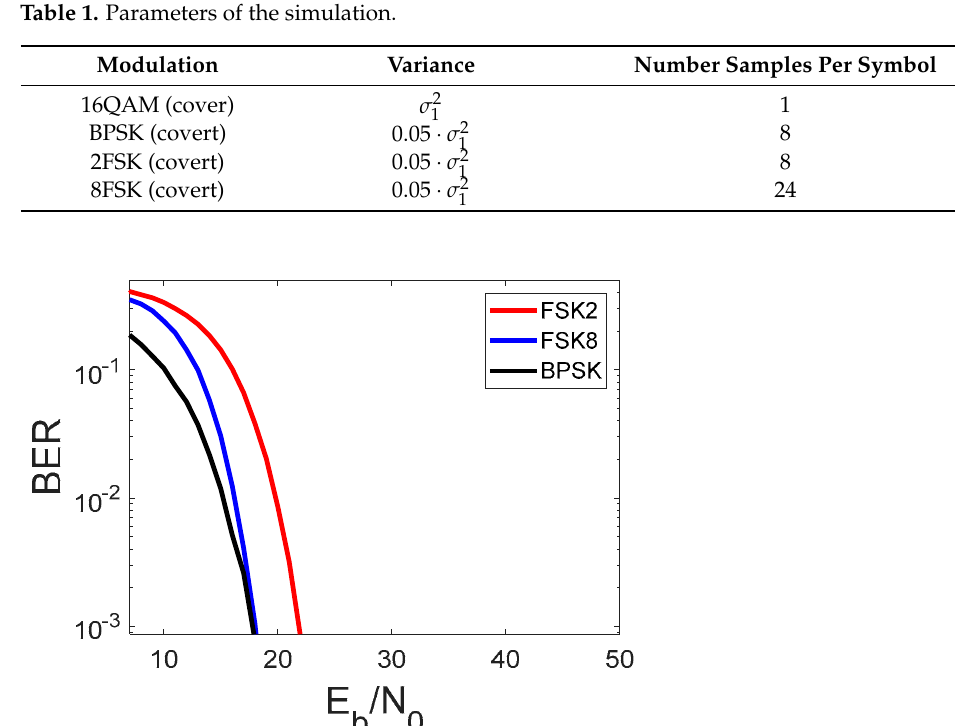
Table 1. Parameters of the simulation.